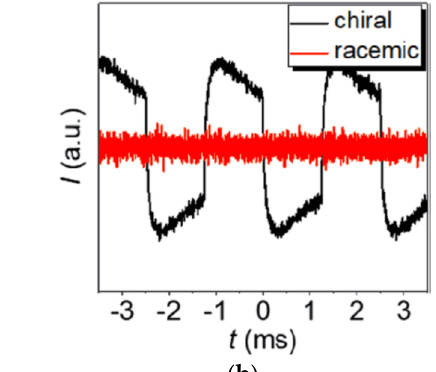
( b ) Figure 25. Signatures of the electroclinic effect in the L 𝛼 * phase of the chiral amphiphile 4 with 23 wt.% of formamide. ( a ) Electroclinically induced tilt angle δθ versus amplitude E of a 400 Hz square-wave electric field at a fixed temperature of 0.5 K above the transition temperature into the lyo-SmC* phase. The straight line shows the linear regime of δθ ( E ). ( b ) δθ versus temperature T at a fixed amplitude E = 1.9 V/µm of the 400 Hz square-wave electric field. The solid line shows the Curie–Weiss-like hyperbolic divergence of δθ ( T ). (Reprinted by permission from [69] Copyright 2018 by the American Physical Society.) 5. Conclusions and Outlook After the discovery of ferroelectricity in thermotropic liquid crystals in the 1970s, it has become evidently clear, in recent years, that the lyotropic equivalent to the thermotropic ferroelectric smectic